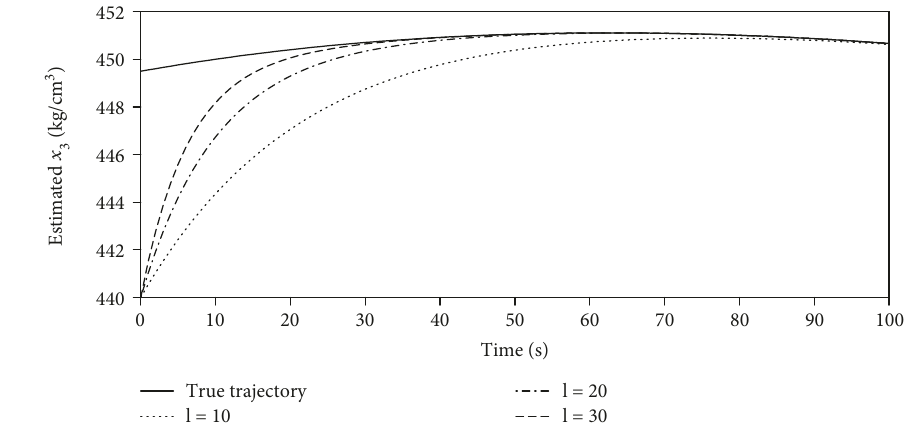
Figure 2: Performance of state observer for x